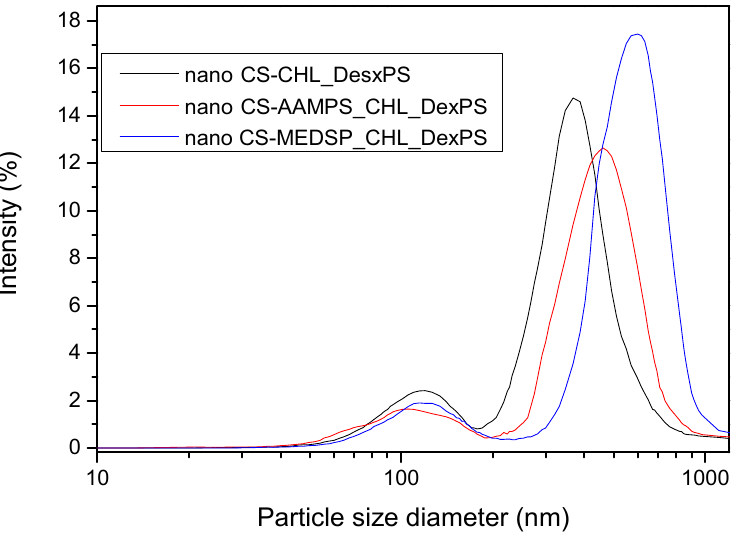
Figure 6. DLS curves of prepared nanoparticles with encapsulated CHL and DexPS drugs.